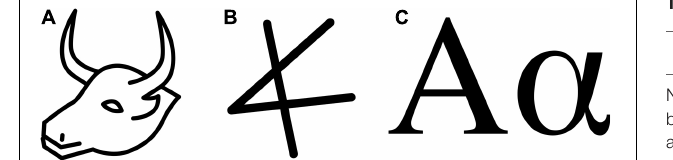
FIGURE 1 | Arbitrarisation. (A) Egyptian hieroglyph representing a bull-head, (B) Phoenician glottal stop [ ĳ ], first letter of the Phoenician alphabet (C) The first letter of the Greek alphabet: Alpha [a] – (as a capital and as a small